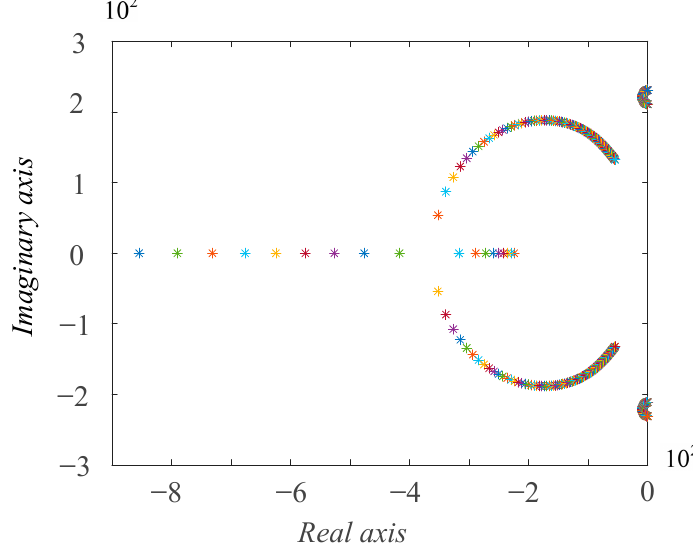
Figure 7. The root locus of the system Jacobian matrix.